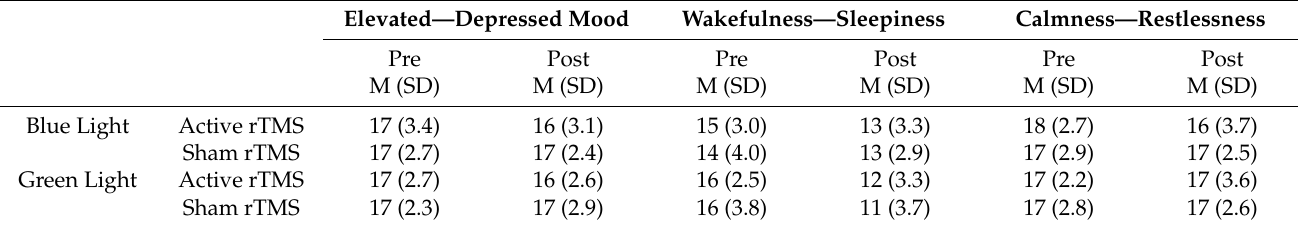
Table 3. Mood assessment before (pre) and after (post) light exposure combined with rTMS. Elevated—Depressed Mood Wakefulness—Sleepiness Calmness—Restlessness